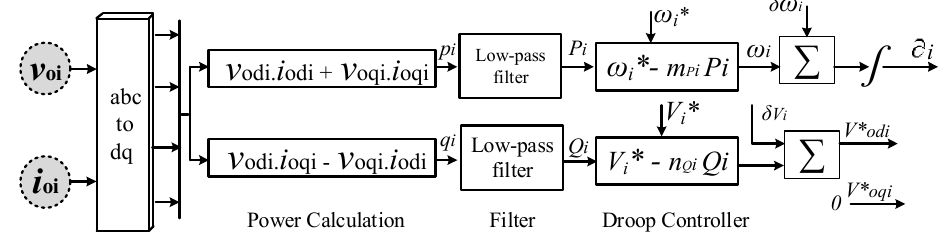
Figure 4. Power controller for i th DG unit. Table 1. Typical line impedance values.